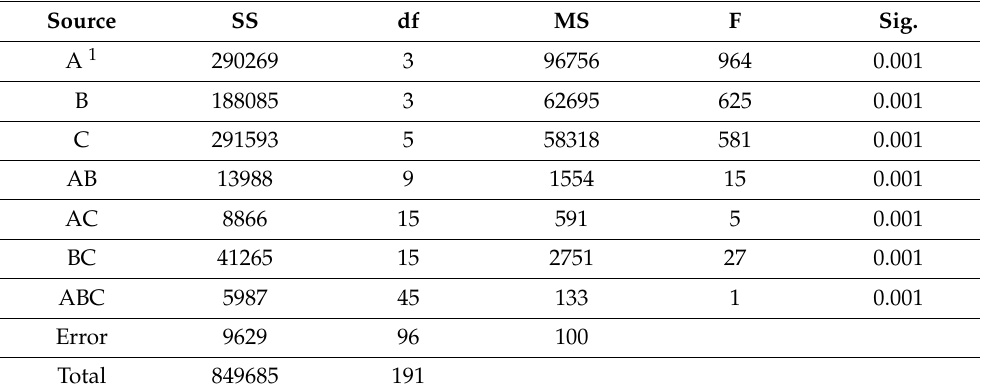
Table 2. Analysis of variance using pressure, amount of α -tocopherol, and storage time as